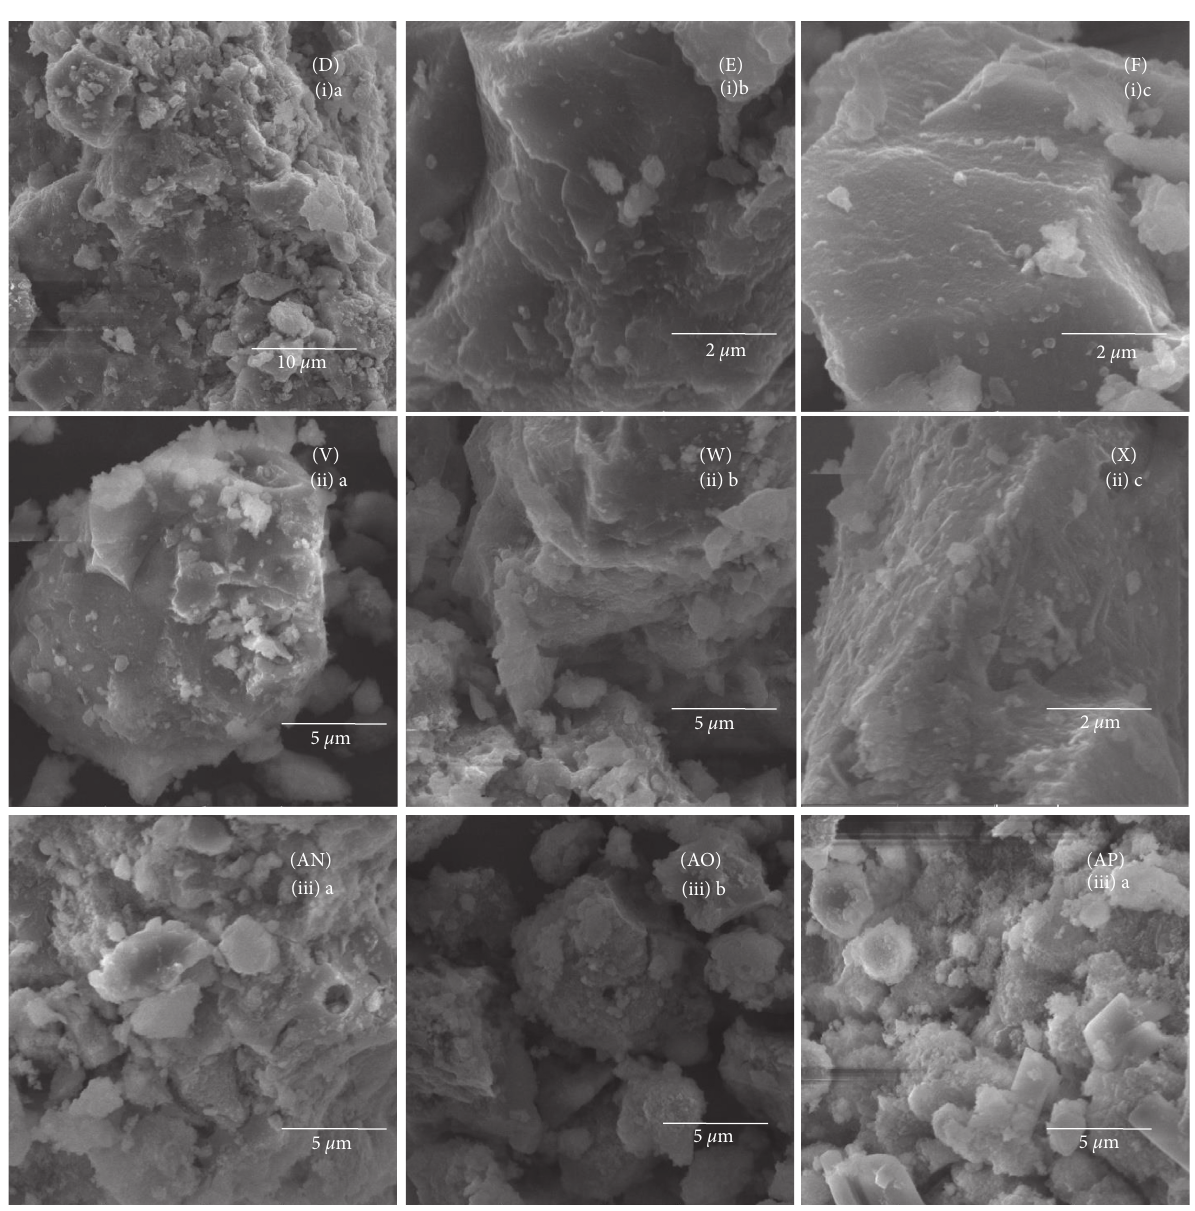
Figure 4: SEM images of geopolymer paste with 5M of